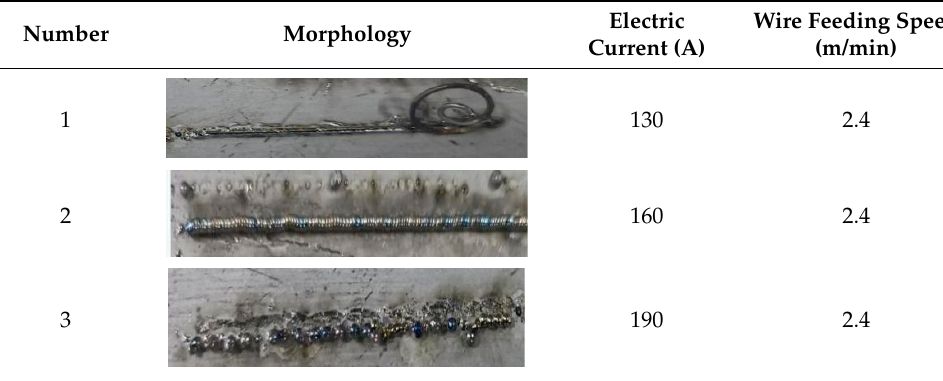
Table 3. Influence of current on forming appearance.